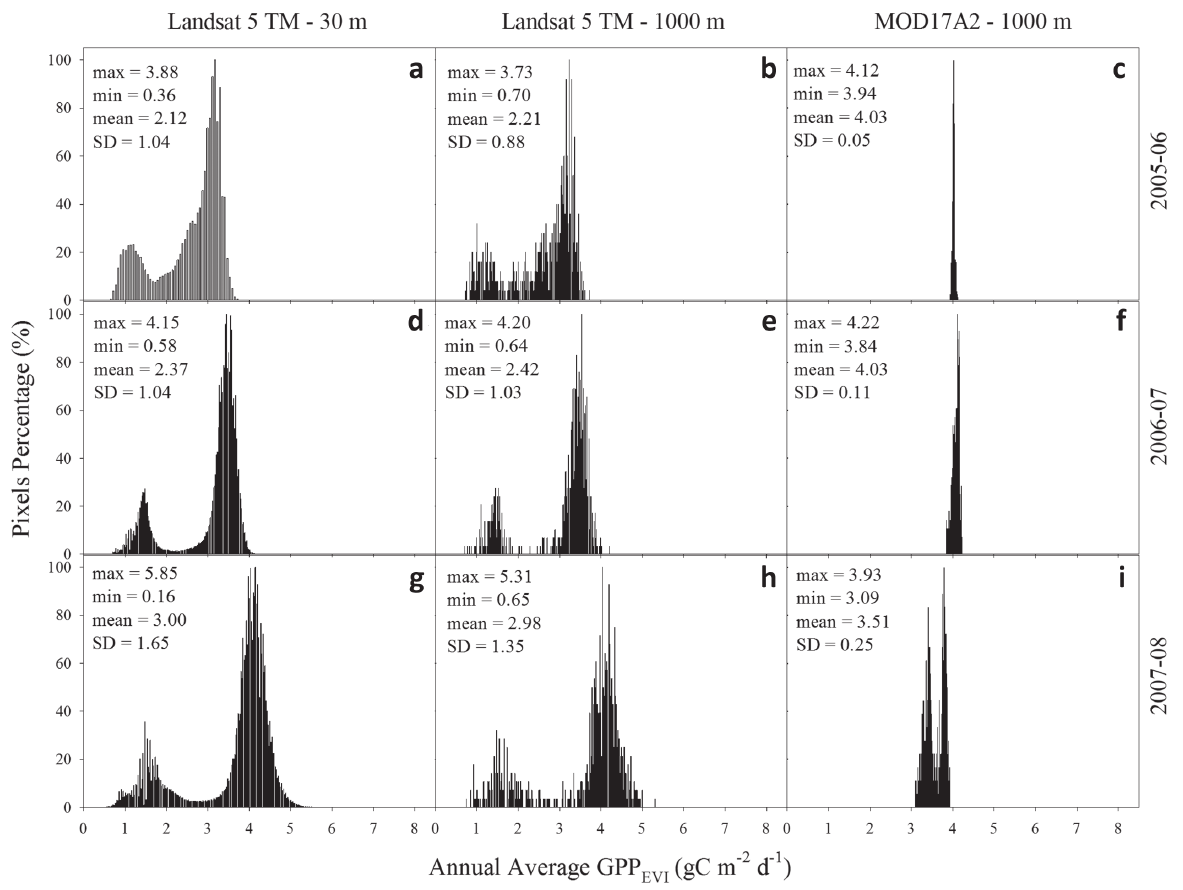
Fig. 6 - Histograms of maps of annual average GPP estimated from Vegetation Photosynthesis Model (VPM) using Enhanced Vegetation Index (EVI) from Landsat 5 TM with 30 m ( a , d and g ) and 1000 m ( b , e and h ) of spatial resolution and by MOD17A2 MODIS GPP Product ( c , f , i ) during 2005-06, 2006-07 and 2007-08,